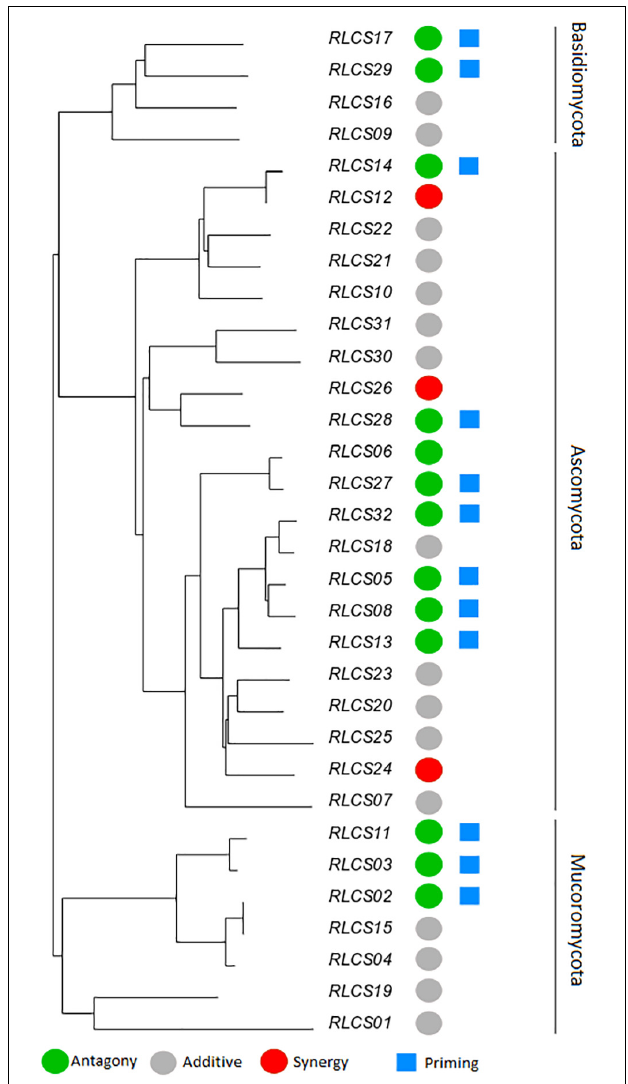
FIGURE 3 | Phylogenetic relationship of a set of soil fungal isolates originating from the same field site with the representation of diverse responses of fungal colony extension rate to recurrent heat pulse perturbations (2 h mild perturbation 35 ◦ C + 1 h strong perturbation 45 ◦ C). The colored circles represent response types: antagony (green) (13 isolates); synergy (red) (3 isolates); additive (gray) (16 isolates). Blue squares mark isolates (12) that showed priming ability [based on criteria of Andrade-Linares et al. (2016)]. The remaining isolates (19) did not meet the criteria of priming ability. The neighbor-joining tree was based on ITS and LSU regions; detailed information on isolates is in Supplementary Table S1